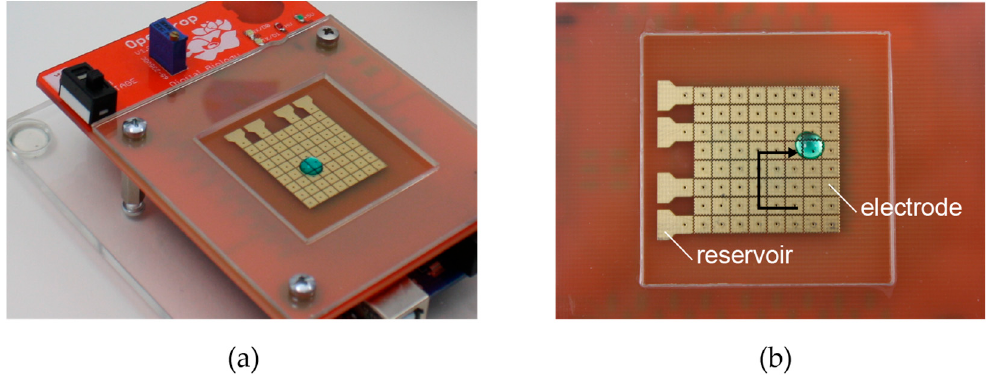
Figure 4. ( a ) O PEN D ROP has an array of 8 × 8 electrodes with four reservoirs; ( b ) The electrodes are reconfigurable and thus they can be used interchangeably.